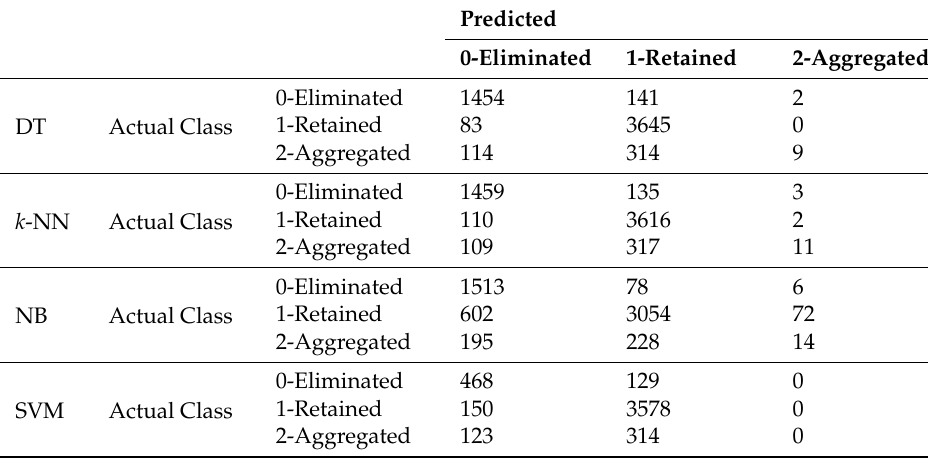
Table 3. Confusion matrix for the test